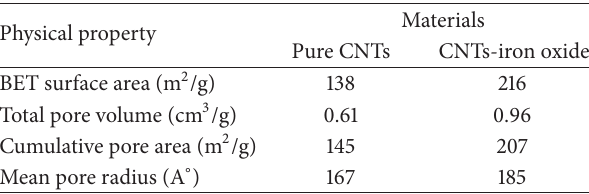
Figure 4: TGA plot of pure and iron oxide impregnated CNTs. Table 1: Surface and structural parameters of pure and iron oxide impregnated CNTs.